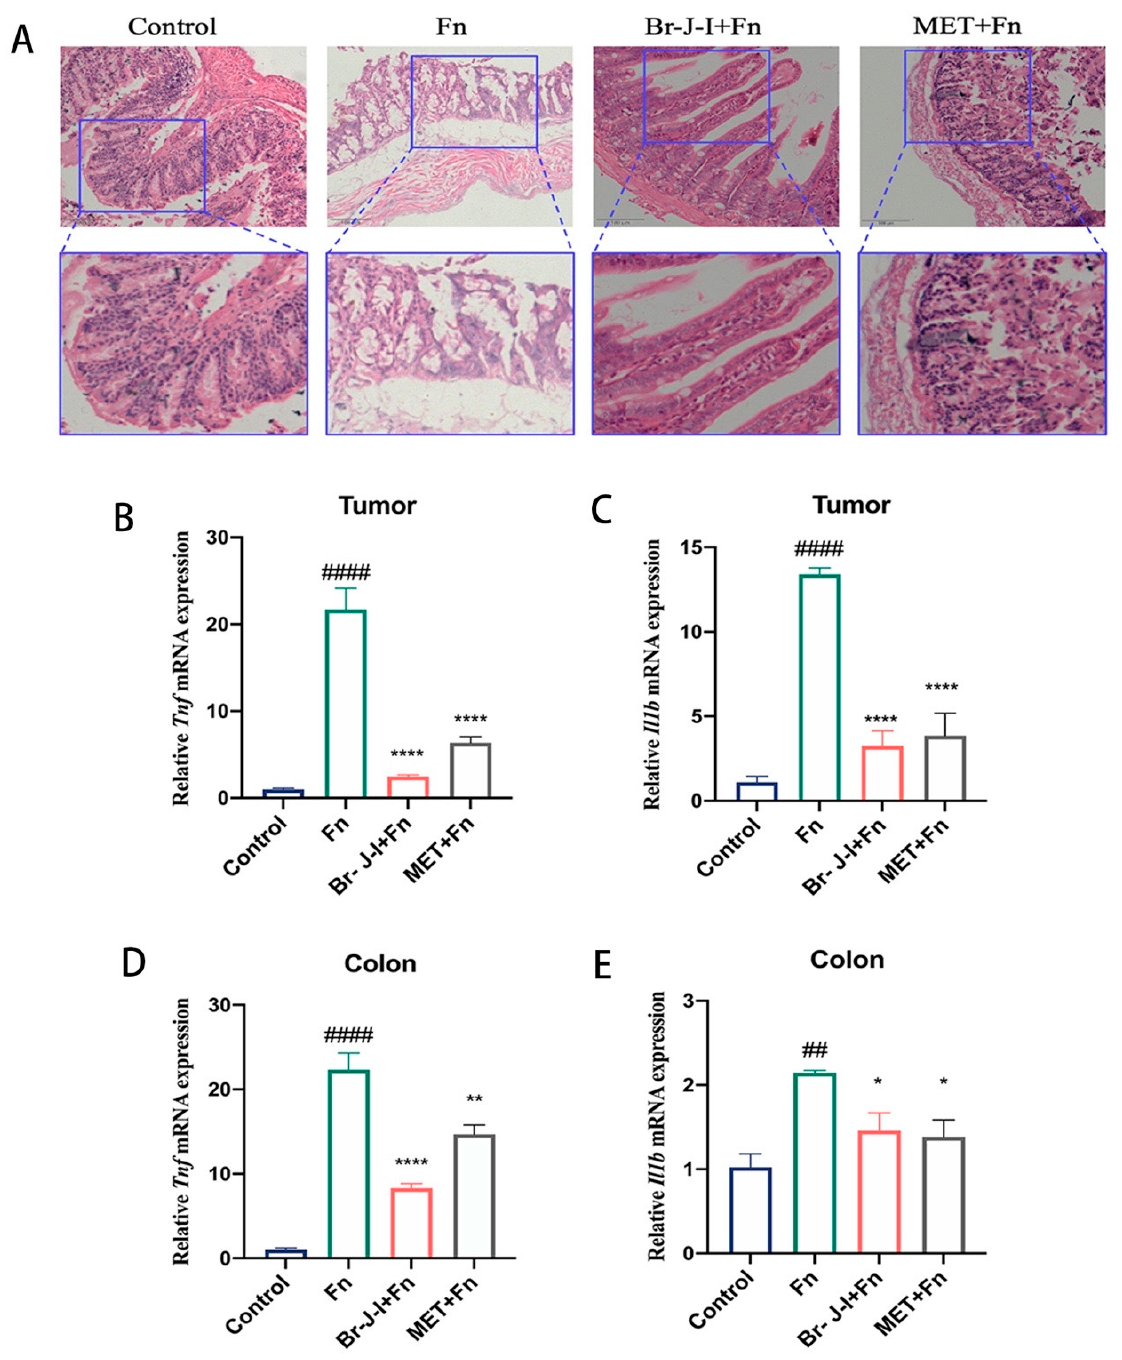
Figure 7. Effect of Br-J-I on the Fn -induced inflammation in vivo. ( A ) H&E staining of colon tissues of HCT116-xenograft-bearing mice to examine the gut inflammation and barrier. Scale bar: 100 µ M (Top), 4-fold magnification of top (Bottom). ( B – E ) Quantification of the expression of genes encoding the proinflammatory cytokines TNF- α ( B , D ) and IL-1 β ( C , E ) in the tumors ( B , C ) and the colon tissues ( D , E ) of the CRC cells-engrafted mice with or without Fn colonization in the presence of Br-J-I (10 mg/kg) and MET (40 mg/kg). All values are represented as mean ± SEM. * p < 0.05, ** p < 0.01, **** p < 0.0001, vs. Fn group. ## p < 0.01, #### p < 0.0001, vs.